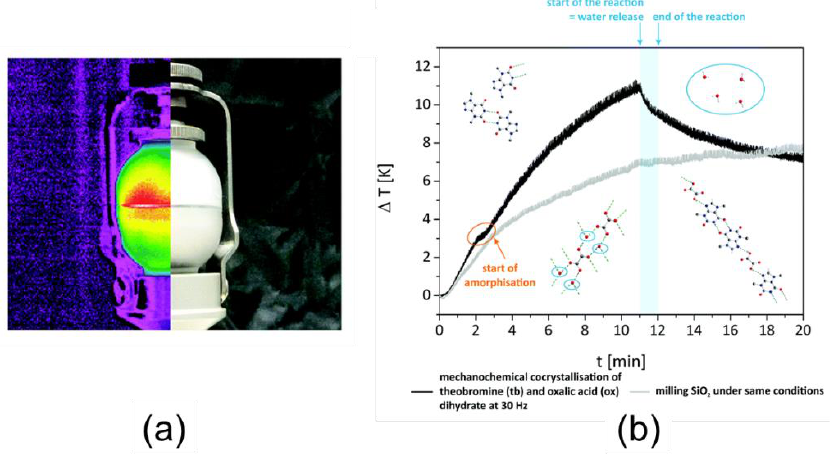
Figure 13. ( a ) Temperature distribution in the vessel measured during the formation of tb:ox co- crystals. ( b ) Time-dependent temperature change inside the milling jar during the reaction (black line) compared to reference SiO 2 powder milled under the same conditions (grey line). Orange: start of the amorphization, blue region: reaction period. The hydrogen bonding system in the crystal structures of the reactants and the co-crystal is shown as insets. Reprinted with permission from [63]. Copyright 2017, Royal Society of